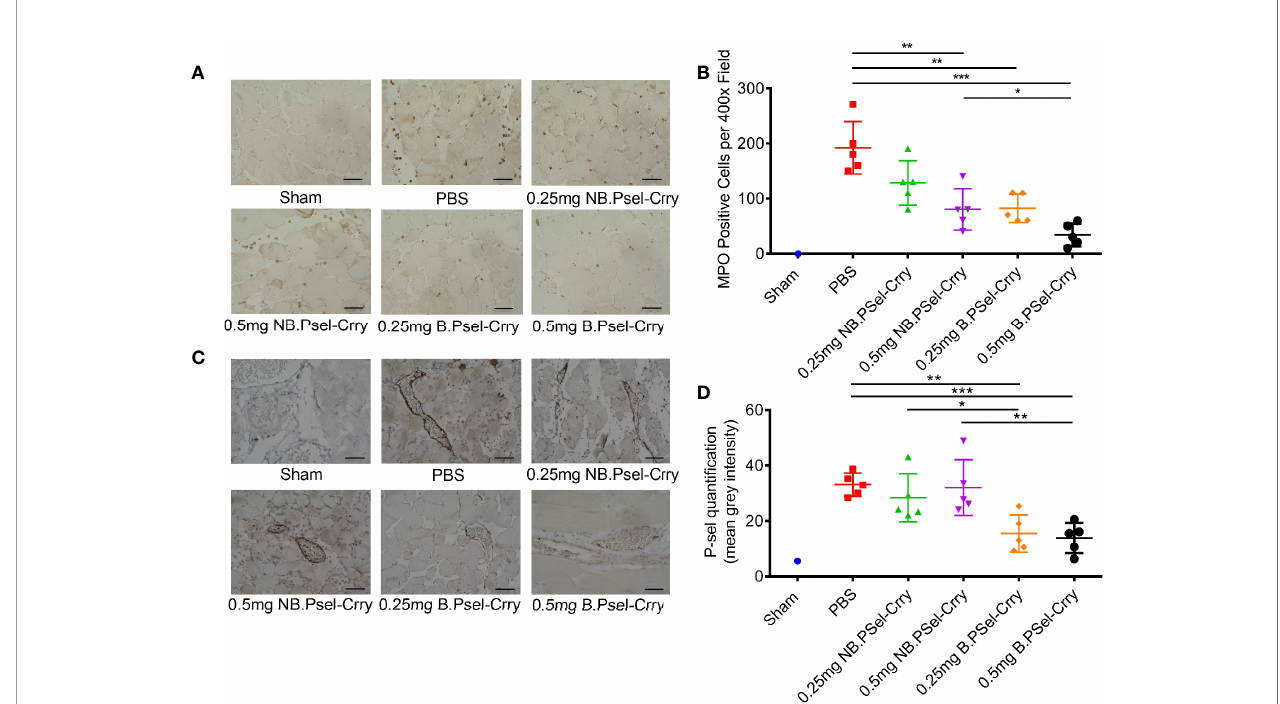
FIGURE 3 | B.PSel-Crry and NB.PSel-Crry reduce in fl ammation markers after hindlimb ischemia and reperfusion. A murine hindlimb IRI model was used to evaluate the effect of B.PSel and NB.PSel administered i.v. upon reperfusion after 2 h ischemia. (A) Representative images of sections stained for MPO. At the higher dose of 0.5 mg, there were lower numbers of in fi ltrating myeloid cells in mice treated with B.PSel-Crry compared to NB.PSel-Crry. Scale bars, 50 m m. (B) Quanti fi cation of in fi ltrating myeloid cells performed by assessing the number of MPO-positive cells per fi eld. Parametric One-way ANOVA with Tukey ’ s correction. (C) Representative images of sections stained for P-selectin. Scale bars, 50 m m. (D) Quanti fi cation of P-selectin expression, which was signi fi cantly lower in B.PSel-Crry treated mice compared to NB.PSel-Crry treated mice at both concentrations. Parametric One-Way ANOVA with Tukey ’ s correction. Quanti fi cation data expressed as Mean ± SD, *p ≤ 0.05, **p ≤ 0.01, ***p ≤ 0.001. n = 5 for all